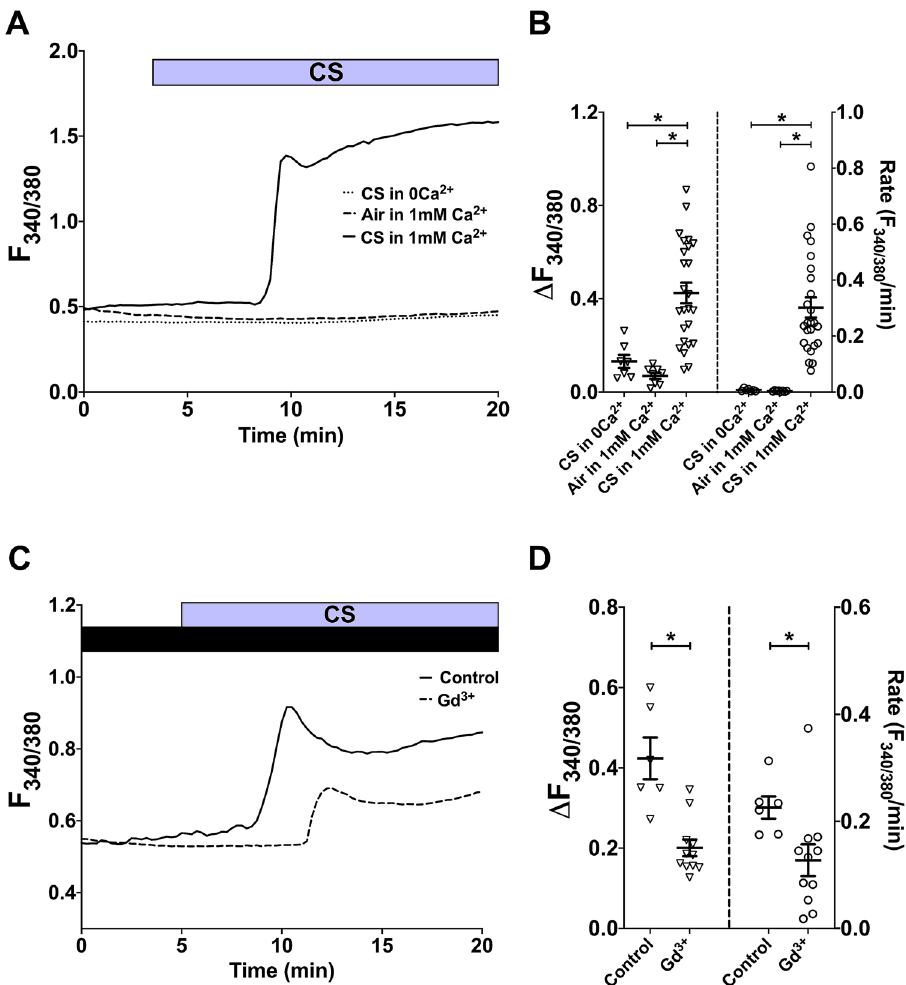
Figure 1. Whole CS activates Ca 2+ influx in hASMC. (A, C) Representative Ca 2+ imaging traces from separate